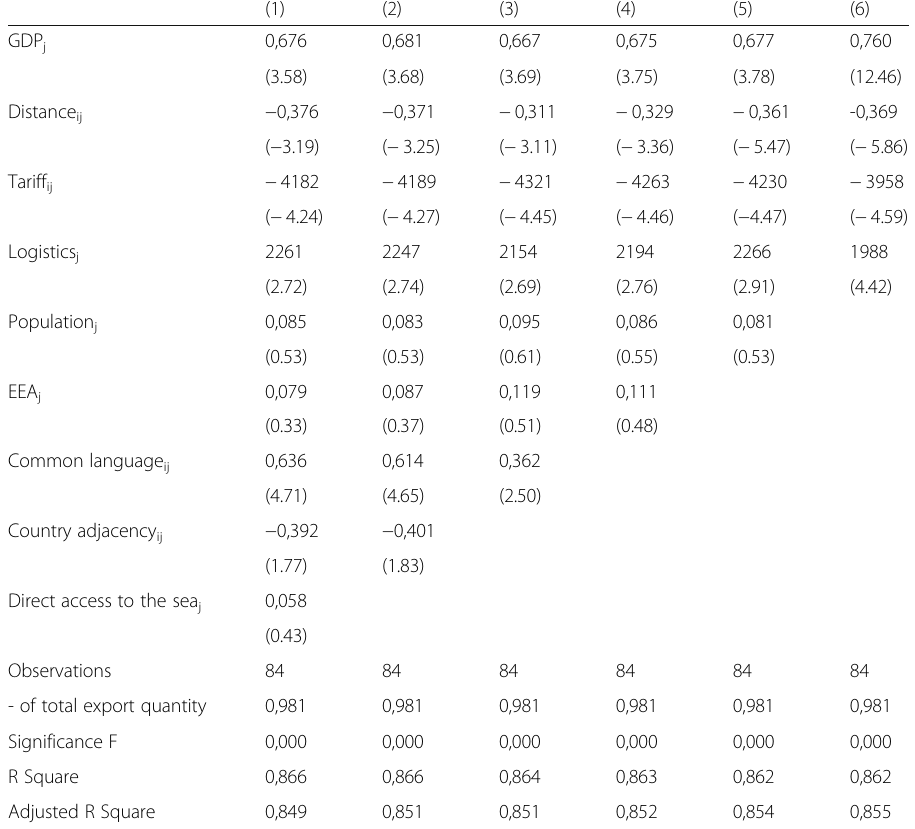
Table 1 Systematic elimination of